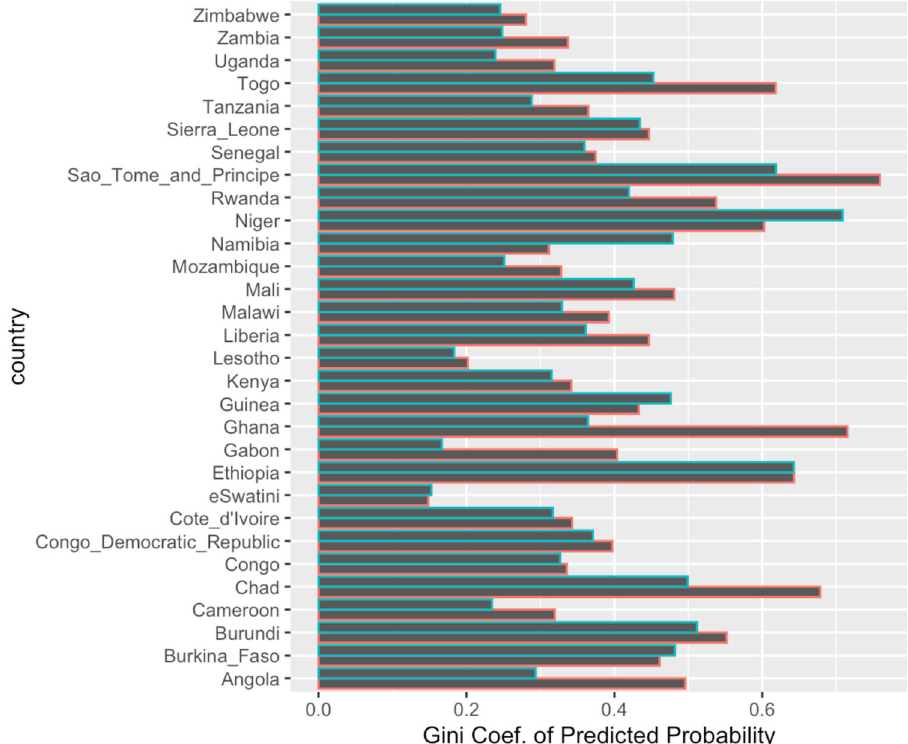
Fig. 5 Concentration of HIV predicted risk (Gini coef fi cient). Gini coef fi cient of the predicted probability per country in Sub-Saharan Africa. Blue boxes are for males, red boxes are for females. Sample sizes for cases and controls for each Gini coef fi cient calculation are in Table